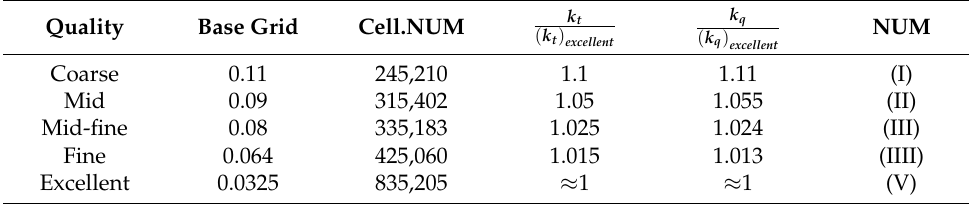
Table 3. Primary data assumed in calculations.